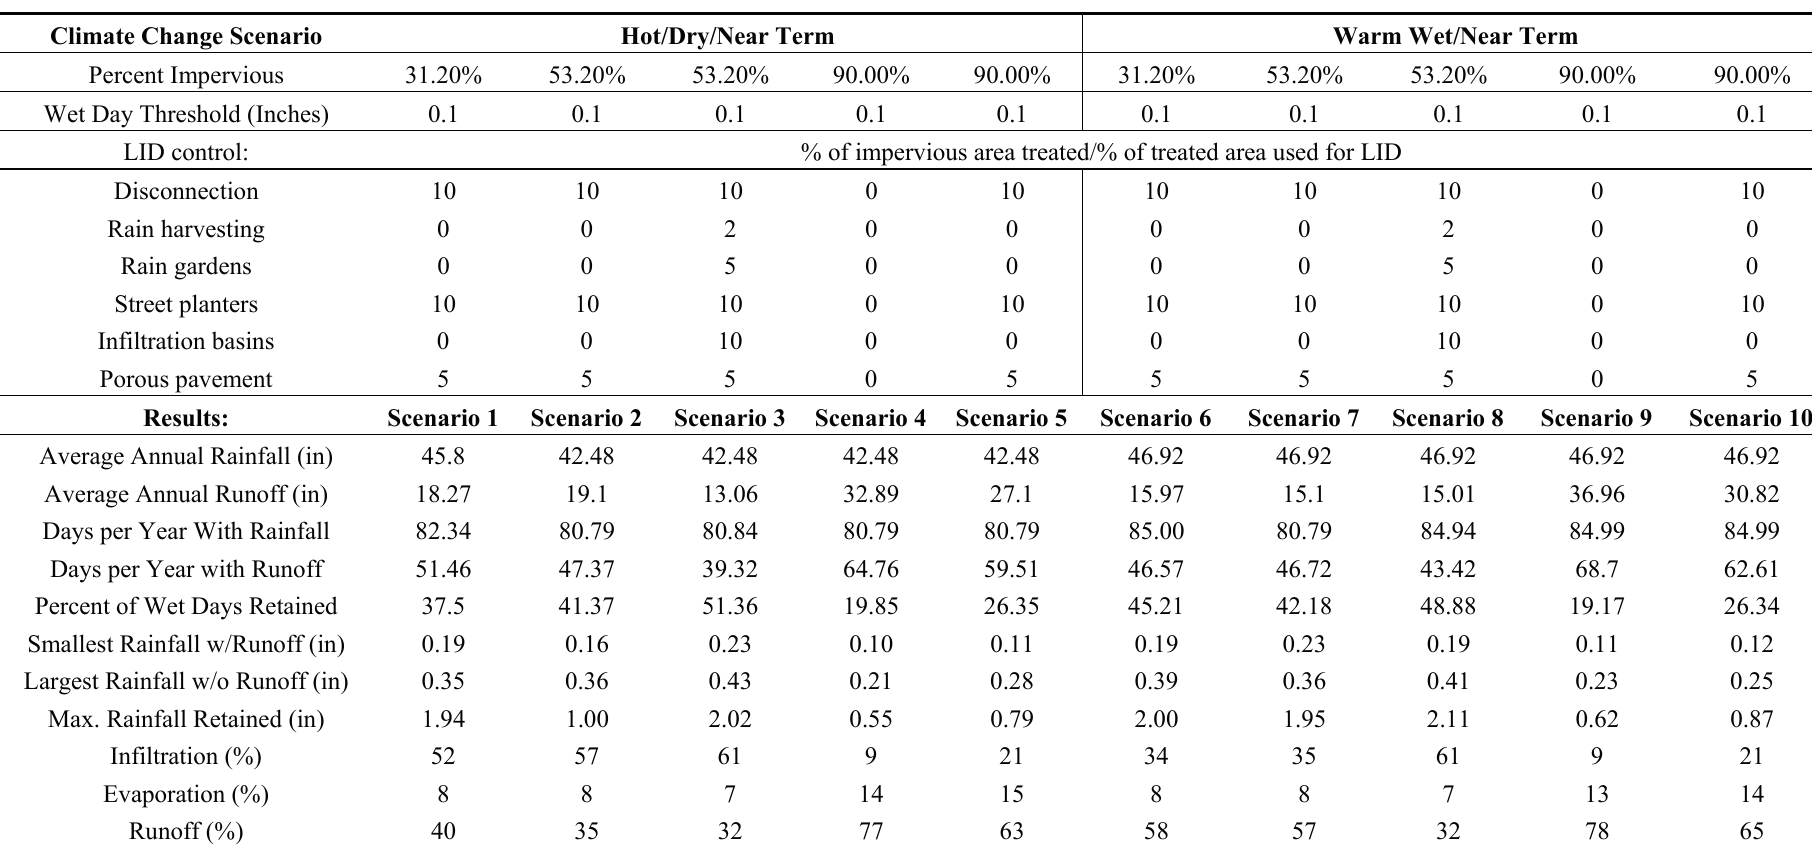
Table 5. Results from sensitivity analysis for two near-term climate scenarios with 20-year time span and various levels of development (% imperviousness) and LID